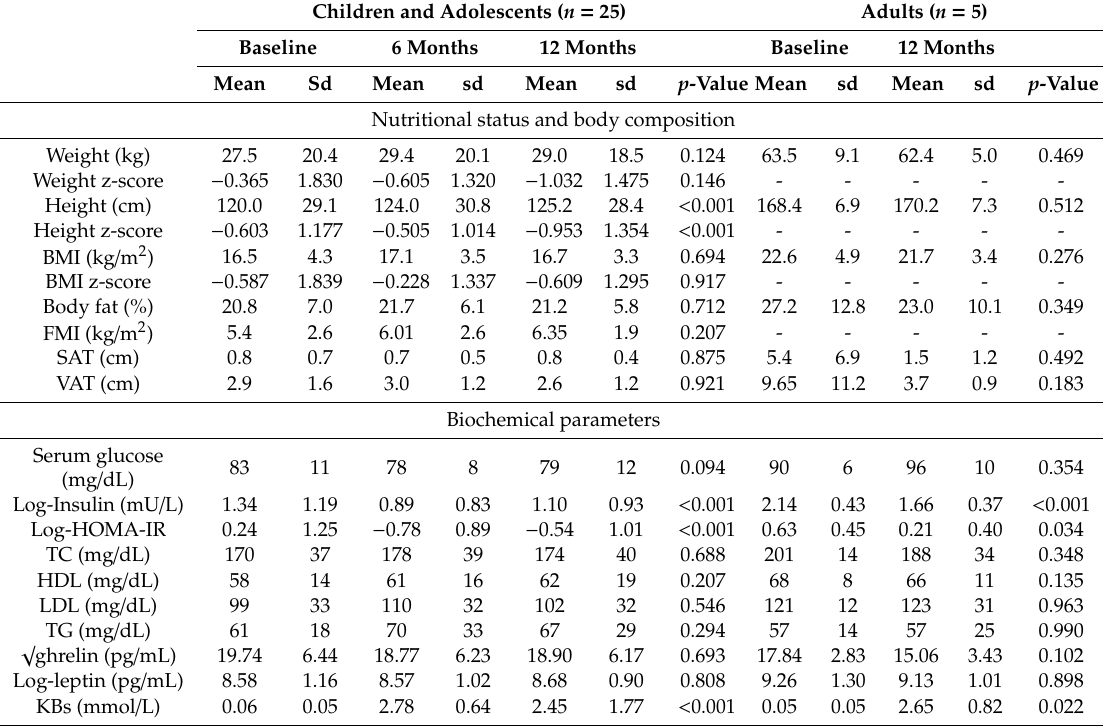
Table 3. Time course of nutritional status, body composition and biochemical parameters during 12-month classical ketogenic diet